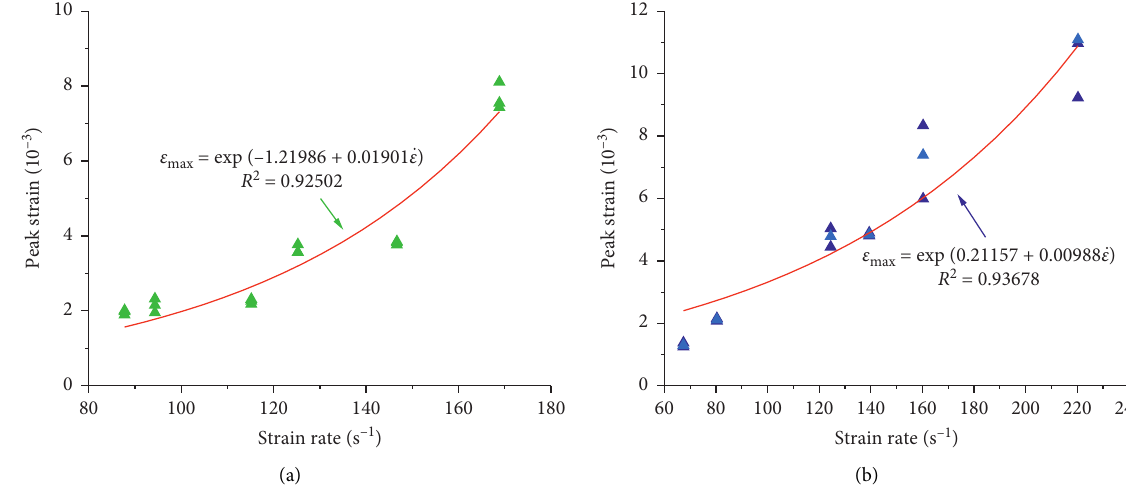
Figure 8: Variation of peak strain with strain rate. (a) Rockburst-prone coal samples. (b) Nonprone coal samples.